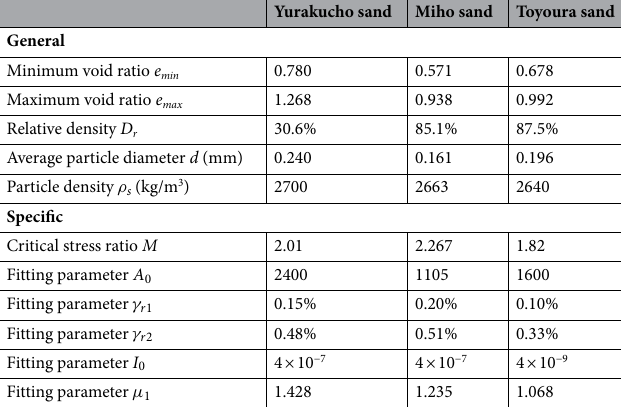
Table 1. Material parameters used for simulations in this paper.